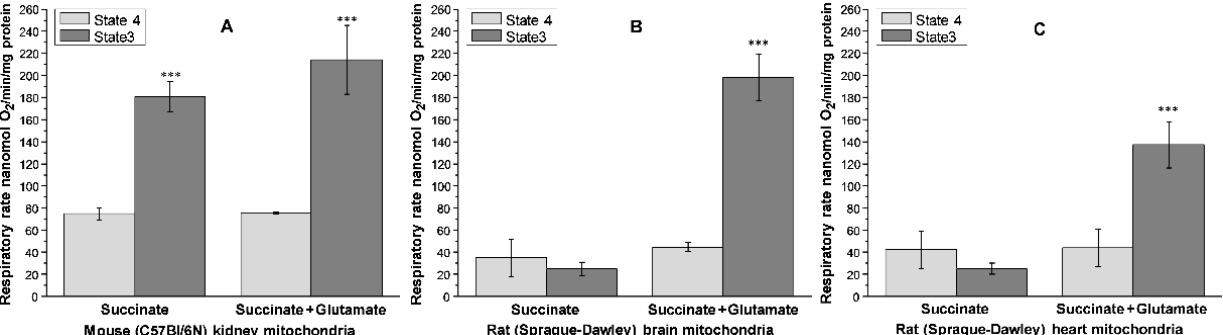
Figure 4. Kidney mitochondria do not possess the intrinsic inhibition of succinate dehydrogenase. Oxygen consumption was measured without ADP (State 4) or with ADP (State 3). ( A ) Mouse kidney mitochondria; ( B ) Rat brain mitochondria; ( C ) Rat heart mitochondria. The data are mean ± standard error. *** p < 0.001 vs. State 4 ( n = 5). Redrawn from ref [75].